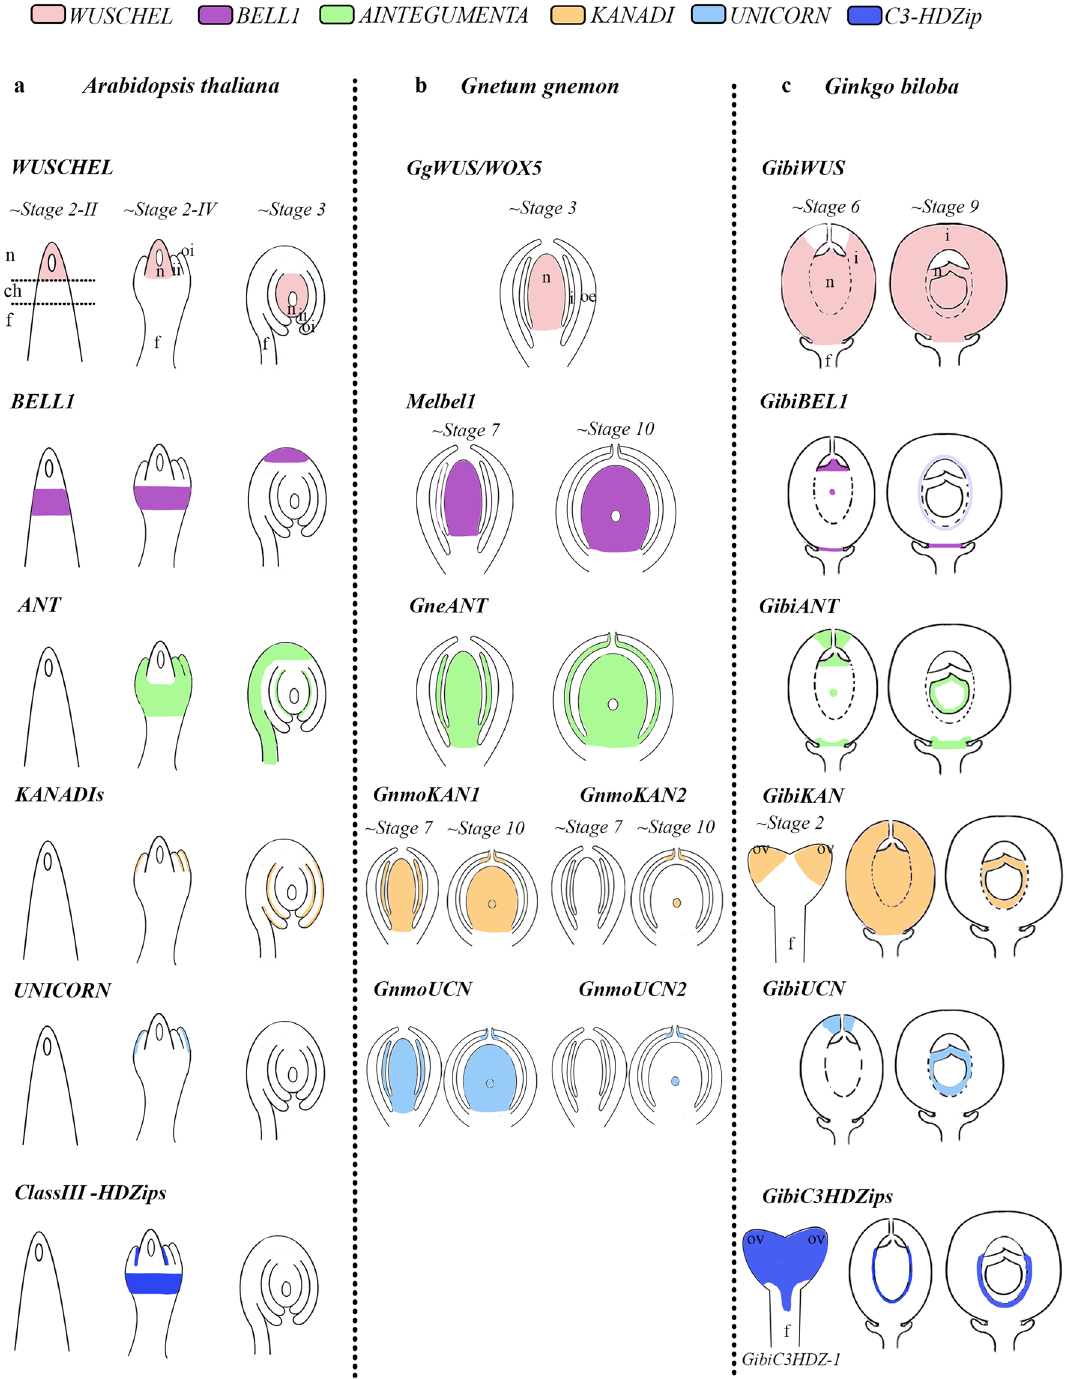
Figure 7. Schematic representation of the expression patterns of integument development genes, in three different species. (a) Arabidopsis thaliana ( WUS by Grobeta-Hardt 16 ; BELL1 by Robinson-Beers et al. 58 ; ANT by Elliot et al. 15 ; KAN by Leon-Kloosterziel et al. 44 ; Eshed et al. 40 ; UCN by Enuguttii et al. 59 ). (b) Gnetum gnemon previously published ( WUS by Nardmannn et al. 2009; Melbel1 , GneANT , GnmoKANs and GnmoUCNs by Zumajo-Cardona and Ambrose 19 ). (c) Ginkgo results presented here. (d) Illustration of telome theory, synangial hypothesis and neo-synangial hypothesis for the origin of the seed. Notably, the telome theory indicates the evolution of integuments from sterile structures while both the synangial and neo-synangial hypotheses indicate the evolution of integuments from fertile (sporangia)